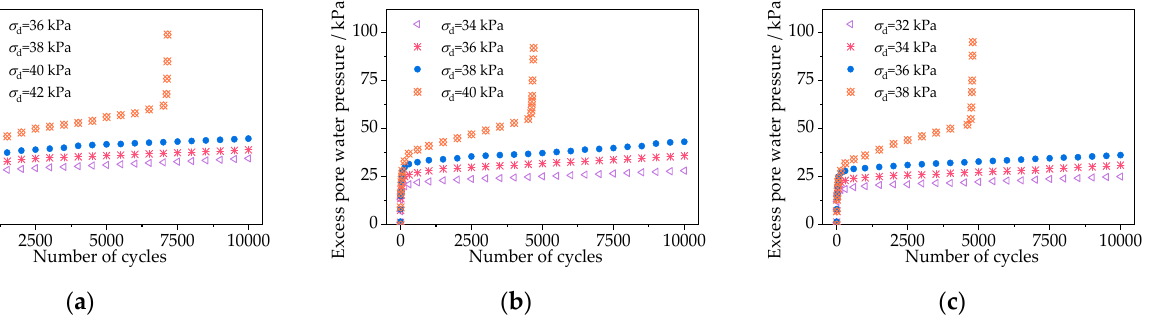
Figure 13. Excess pore water pressure under unloading and reloading stress path. ( a ) CU − 1 (un ‐ loading intensity = 10 kPa); ( b ) CU − 2 (unloading intensity = 20 kPa); ( c ) CU − 3 (unloading intensity = 40 kPa).